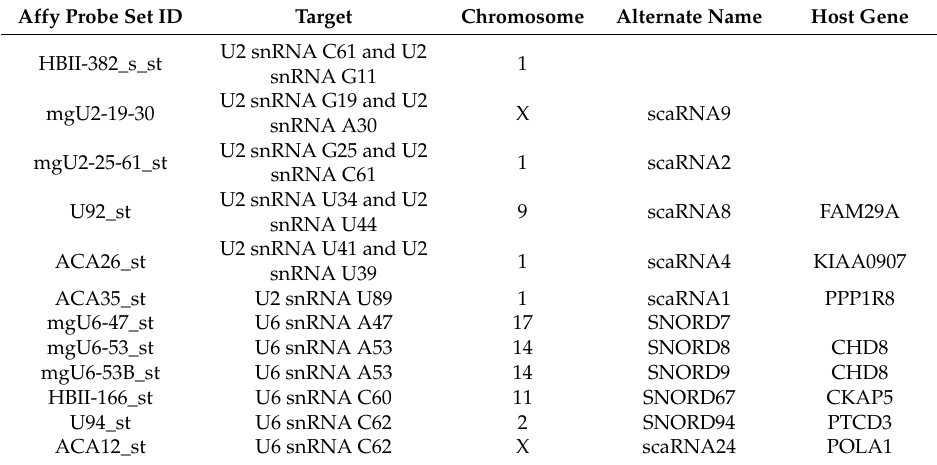
Table 1. 12 scaRNAs with reduced expression in heart tissue from infants with